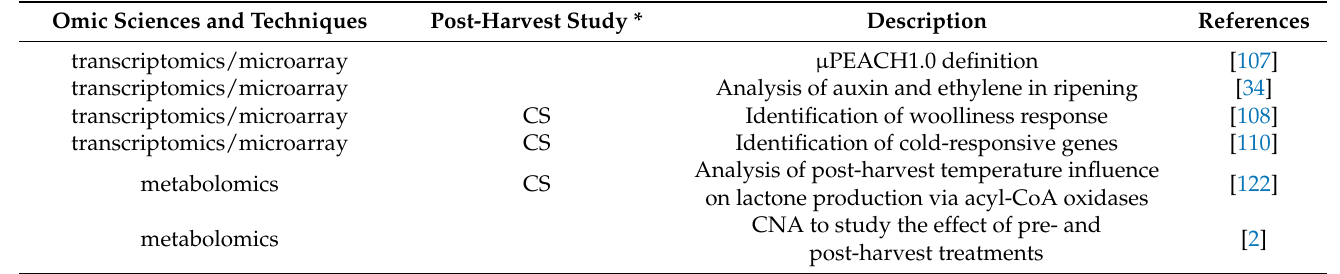
Table 2. Table summarizing many of the most significant single omics studies examined in this review. * indicates the post-harvest treatment applied and ** indicates that the study also focused on other